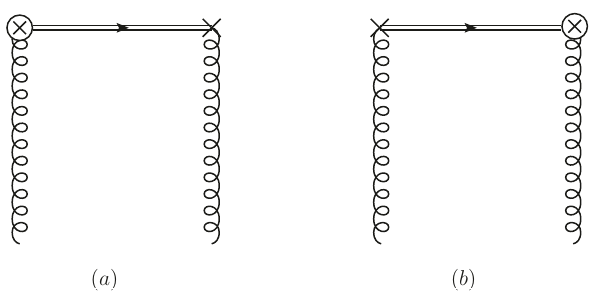
Figure 6 . The tree-level counter-term contribution, where elements of Ω (3)( r. ) zµ or ¯Ω (3)( r. ) zµ